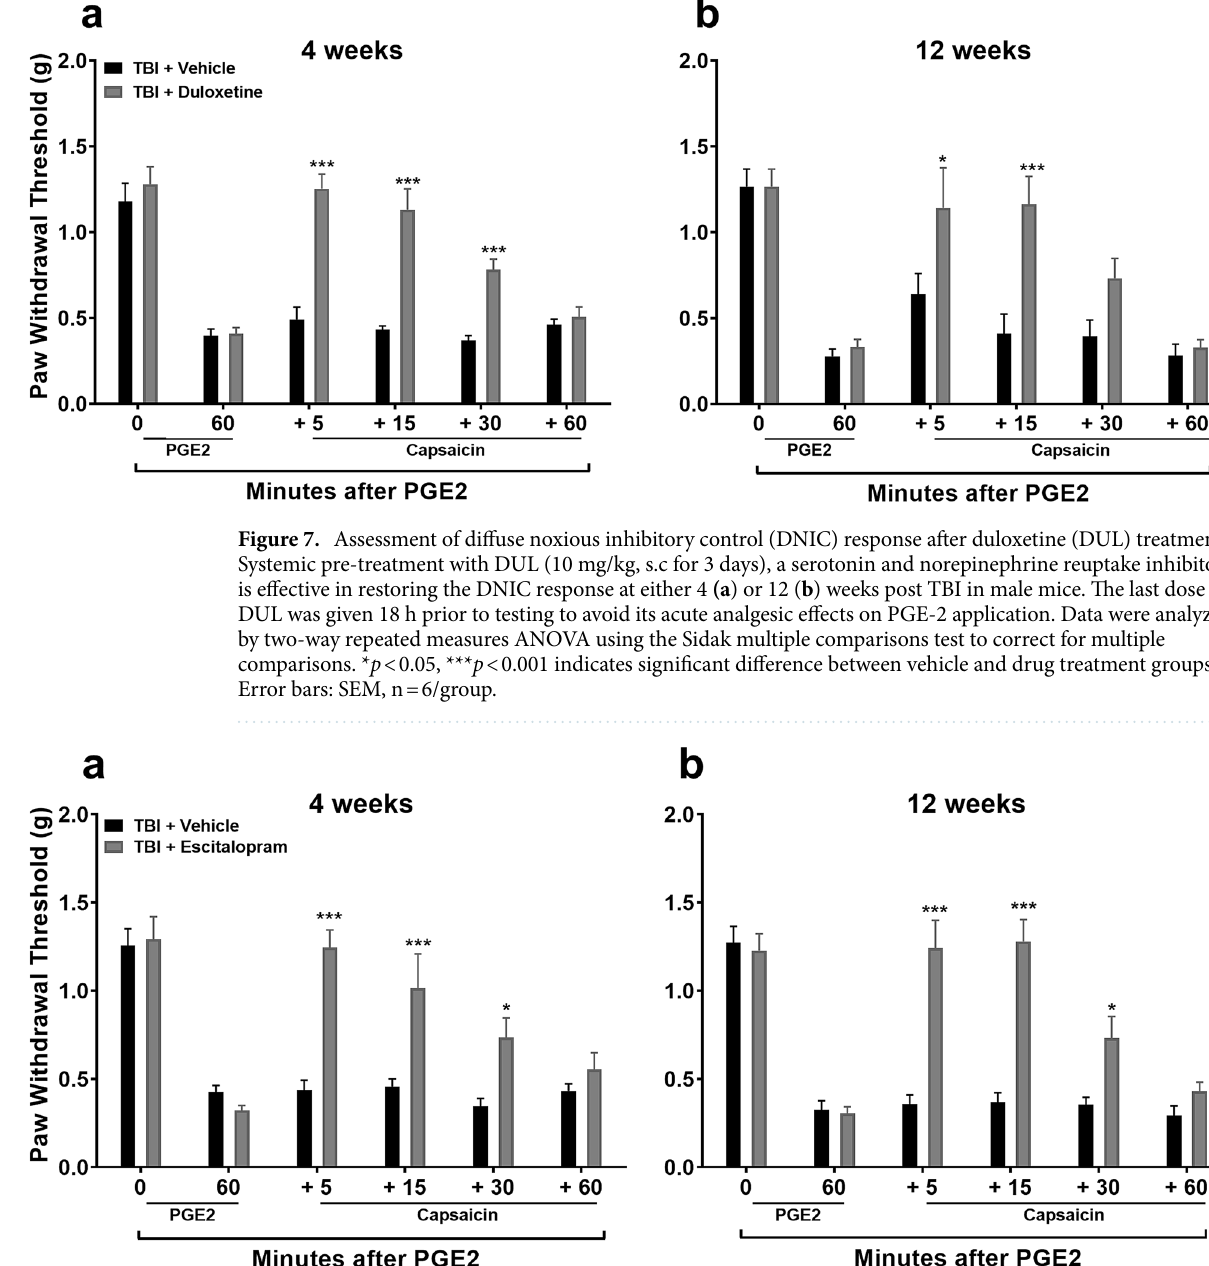
Figure 8. Assessment of diffuse noxious inhibitory control (DNIC) response after escitalopram treatment in TBI. Systemic pre-treatment with the serotonin-selective reuptake inhibitor, escitalopram (ESC, 10 mg/kg, i.p. for 3 days) does restore the DNIC response at either 4 ( a ) or 12 ( b ) weeks post TBI in male mice. The last dose of ESC was given 18 h prior to testing to avoid any potential acute analgesic effects of ESC on PGE 2 application. Data were analyzed by two-way repeated measures ANOVA using the Sidak multiple comparisons test to correct for multiple comparisons. * p < 0.05, *** p < 0.001 indicates significant difference between vehicle and drug treatment groups.Error bars: SEM, n =